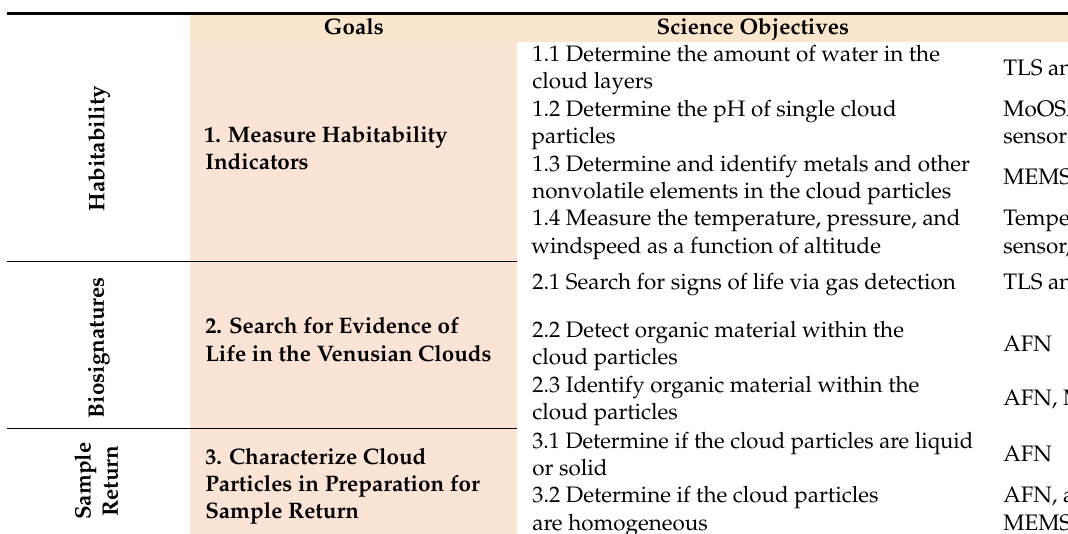
Table 1. Venus Habitability Mission science goals, objectives, and instruments. TLS = Tunable Laser Spectrometer, MoOSA = molybdenum oxide sensor array, TOPS = Tartu Observatory pH sensor, MEMS = micro-electro-mechanical systems, MEMS-A = MEMS aerosol elemental analyzer, MEMS-G = MEMS gas molecule analyzer, AFN = autofluorescence nephelometer. See Section 2 for a description of science goals and objectives, and Section 3 for a description of the